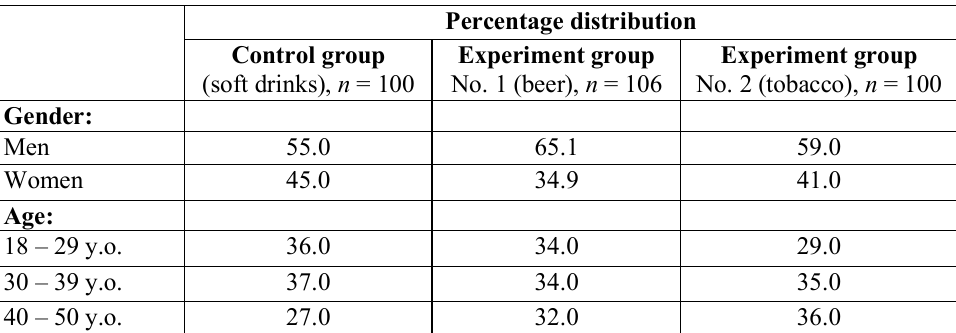
Table 1. Demographic characteristics of experiment